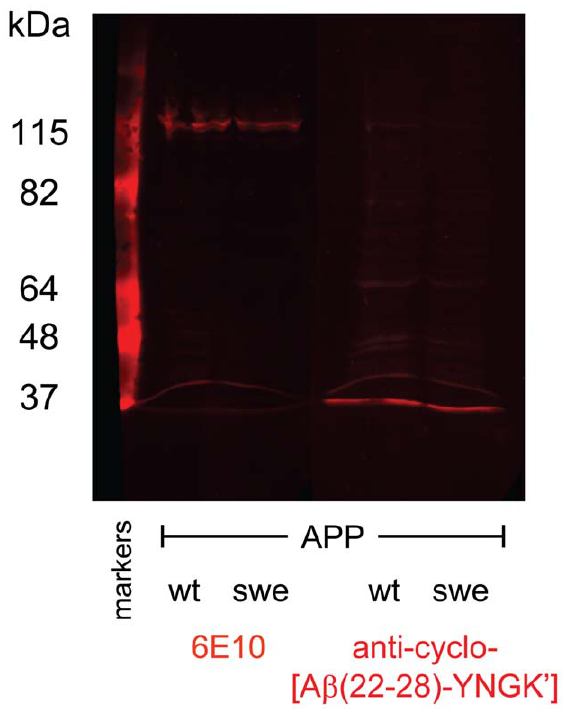
Figure 4. Western blot of a lysate of SW13 adrenal cells transfected with amyloid precursor protein (APP). The cells were transfected with either human APP 695 wt (wild type) or with APP 695 swe (Swedish mutation). Monoclonal antibody 6E10 is specific for the largely unstructured N-terminus of amyloid b (A b ) and recognized both APPs (amino acid residues 2–8 in A b correspond to residues 598–604 in APP 695 ). Anti-cyclo[A b (22–28)-YNGK 9 ] antibodies stained neither of the APPs under the denaturing conditions of the assay and thus seem